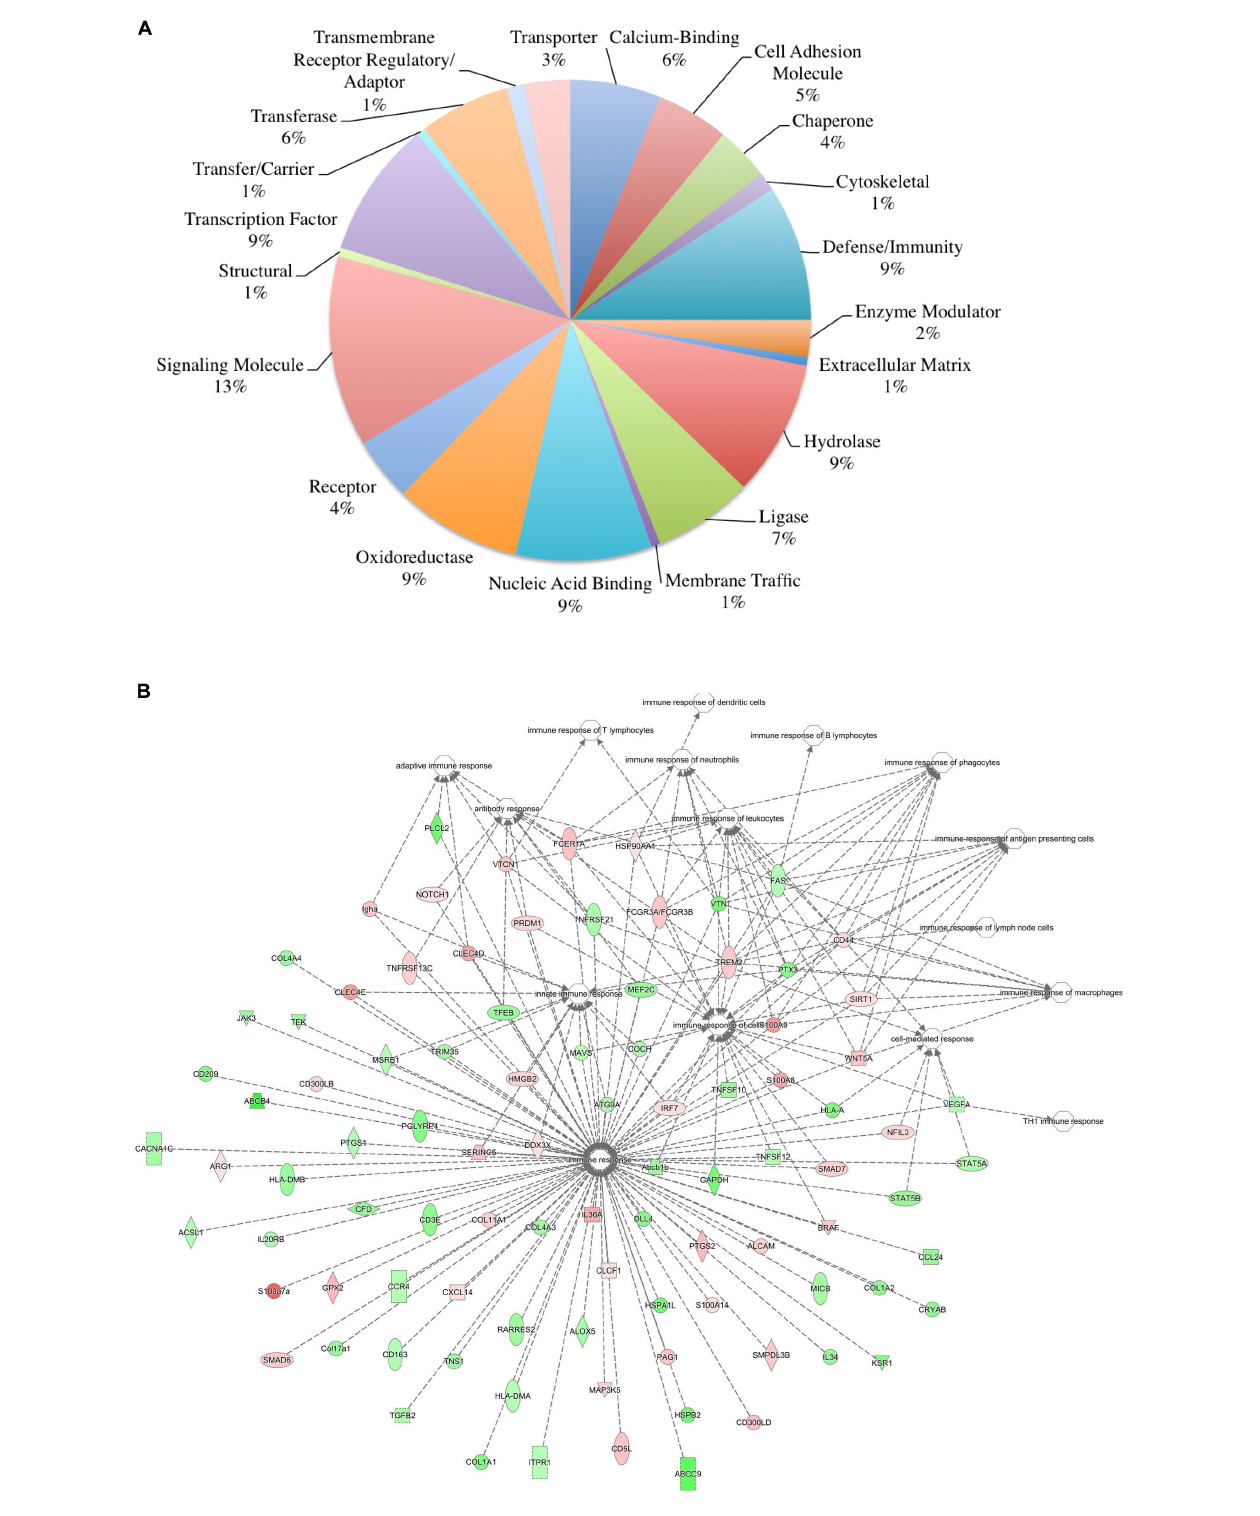
FIGURE 5 | Overall immune response-associated transcriptional changes observed in C57BL/6 versus IL-6-deficient (KO) normal skin. Total RNA was isolated from untreated C57 and IL-6KO (KO) skin samples and subjected to transcriptome analysis by MiSeq ( n = 6/experimental group). Differential gene lists were created with two-fold expression cutoff and significant FDR of < 0.1. (A) PANTHER protein class pie chart of all genes significantly modulated. (B) IPA network association of all genes significantly modulated with a known immune-associated function.